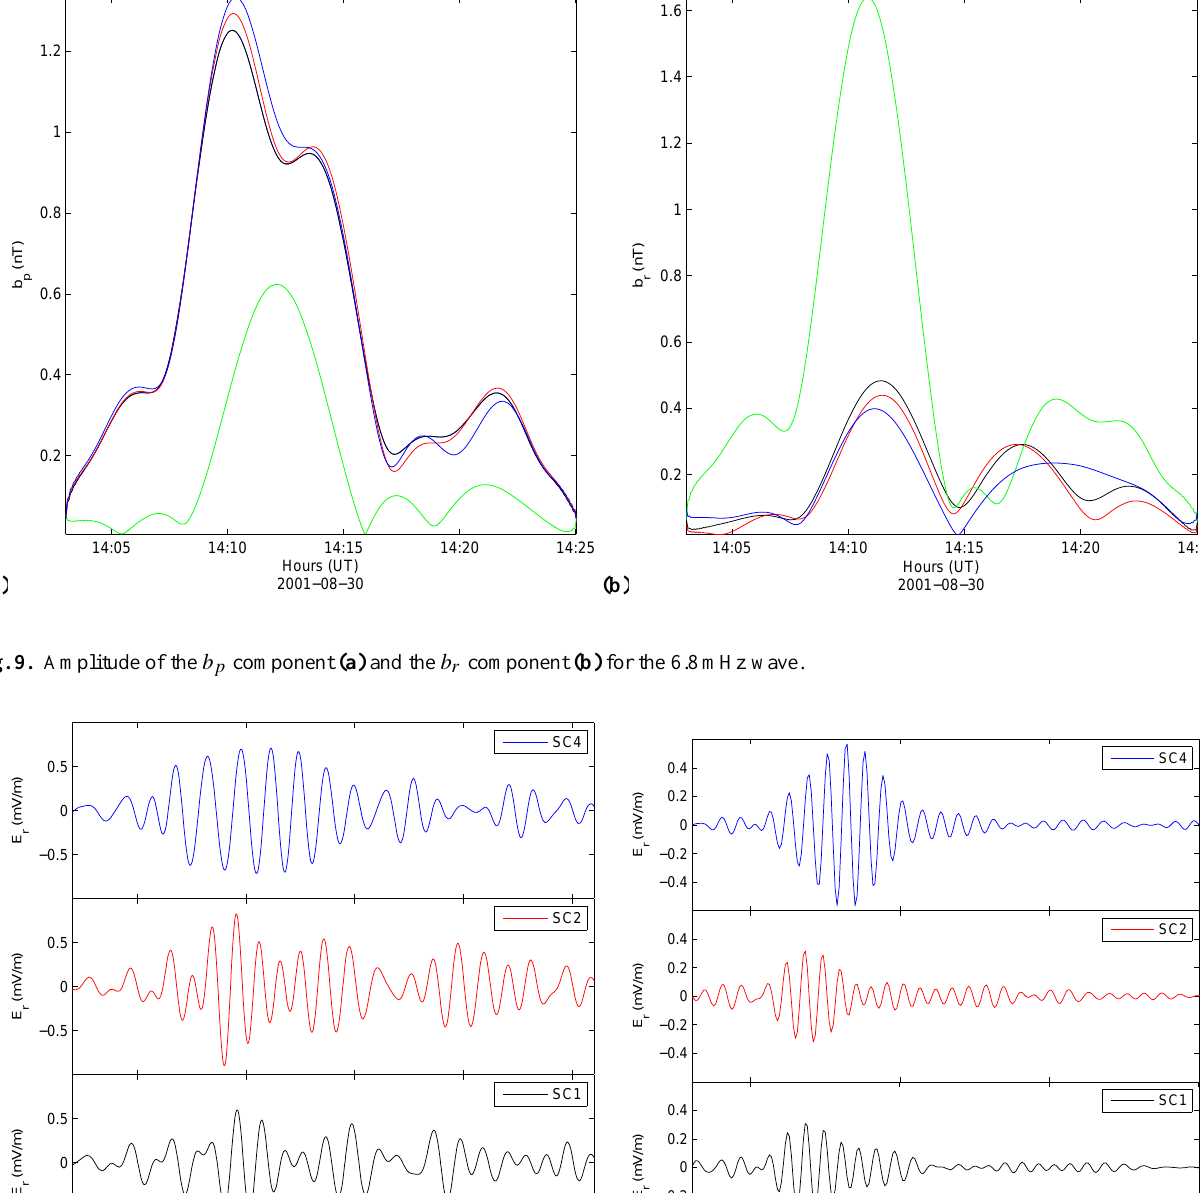
In Fig. 9 we have plotted the instantaneous amplitude of the b p and b r components of the 6.8 mHz wave for the time interval 14:02 UT to 14:25 UT. Here we have obtained the in- stantaneous amplitude by computing the analytic signal for the bandpass filtered data. Thus, these plots illustrate the